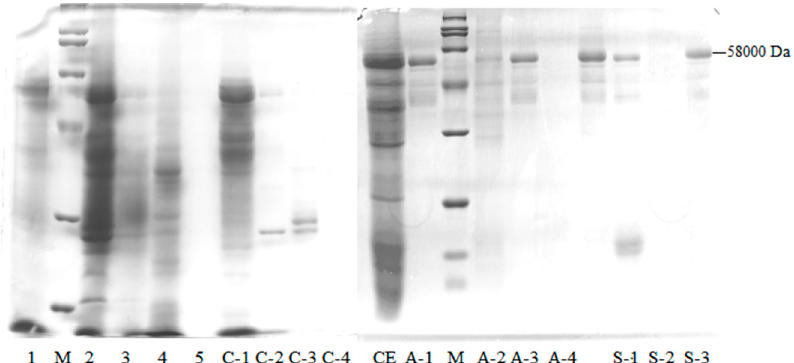
Figure 2. SDS-PAGE of the endo-1,4- β -xylanase. Lane CE represent crude enzyme; Lanes 1, 2, 3, 4, and 5 represent AS0-20, AS20-40, AS40-60, AS60-80, and AS80-100, respectively; Lanes C-1, 2, 3, 4 represent the four peaks eluted by SP-Sepharose Fast Flow cation chromatography, respectively; Lanes A-1, 2, 3, 4 represent the four peaks eluted by Q-Sepharose Fast Flow anion chromatography, respectively; Lanes S-1, 2, 3 represent the three peaks eluted by Source 30Q anion-exchange chromatography, respectively; M is the protein marker. Note: from top to bottom, the molecular weights of protein markers are 200, 116, 97.2, 66.4, 44.3, 29.0, 20.1, 14.3, and 6.5 kDa.